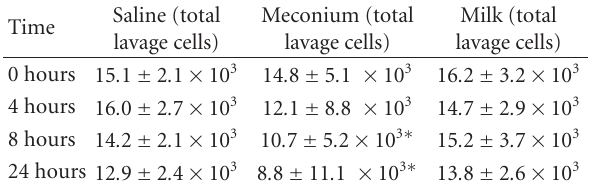
P < . 05 versus 0hrs Meconiumgroupdemonstratedalowertotallavagecellnumbercompared to saline and milk groups. At 8 and 24hrs after meconium instillation, the decrease of cells is significantly lower ( P < . 05) than baseline. 20-fold increase in protein content meconium group compared to saline group and about 4-folds compared to milk group. Instillation of milk (b) Total lung lavage cell count after exposure to hypoxia and hyperoxia. resulted in about 8–10-fold increase of total protein content compared to saline ( ∗ P < . 05). Please note that values at 0hr indicate preinstillation Hypoxia group Hyperoxia group Time baseline values in each group. (total lavage cells) (total lavage cells) 15min 12 . 62 . 5 × 10 3 (b) Total protein levels after in hypoxic or hyperoxic conditions in lung lavage (mg/ml). Lavage from hypoxic animals contained lower number of total cells, compared to hyperoxia group.